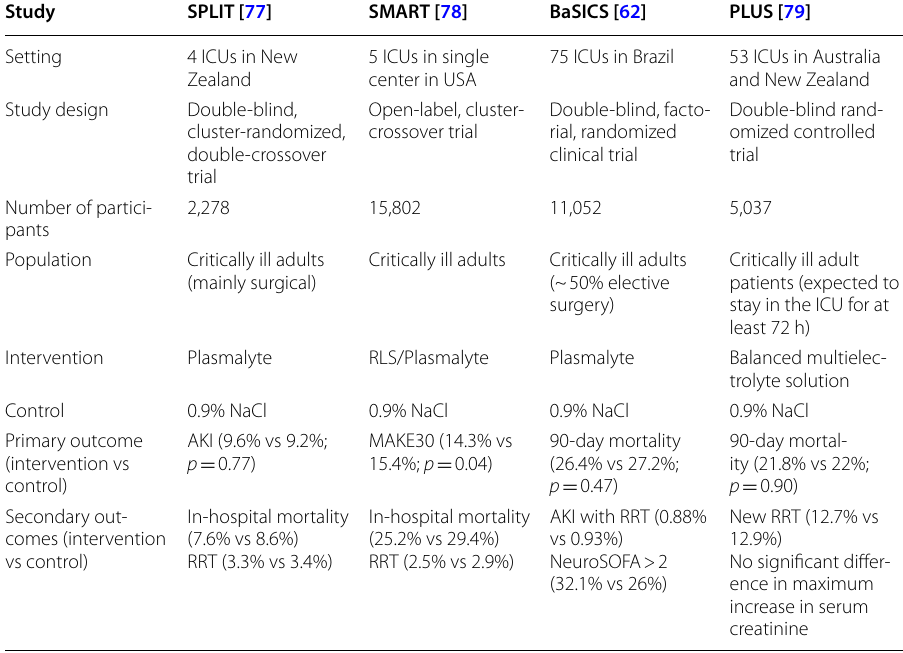
ICU intensive care unit, RLS ringer-lactate solution, AKI acute kidney injury, MAKE30 clinical outcome consisting of death from any cause, new renal replacement therapy or persistent renal dysfunction within 30 days, NaCl saline solution, RRT renal replace therapy, SOFA sequential organ failure assessment